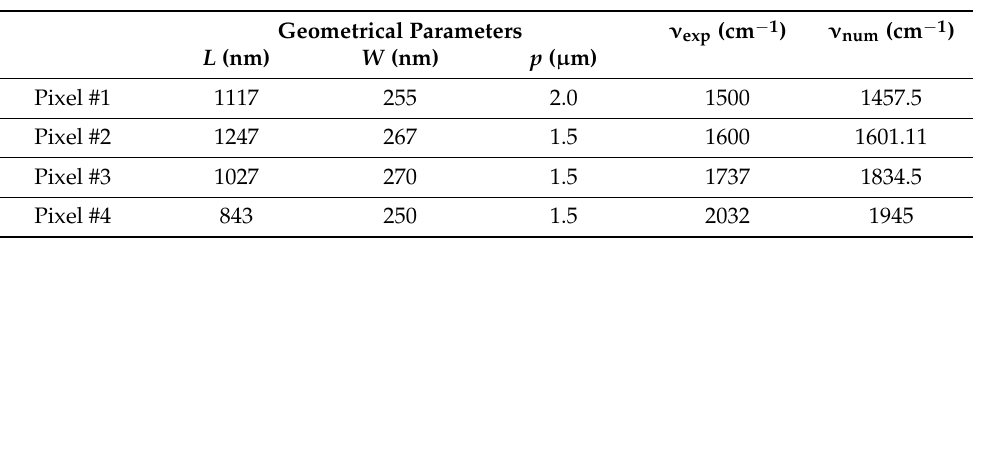
Table 1. Experimental geometrical dimensions of each NA constituting the different pixels of our proposed MS, and corresponding experimental and numerical resonant